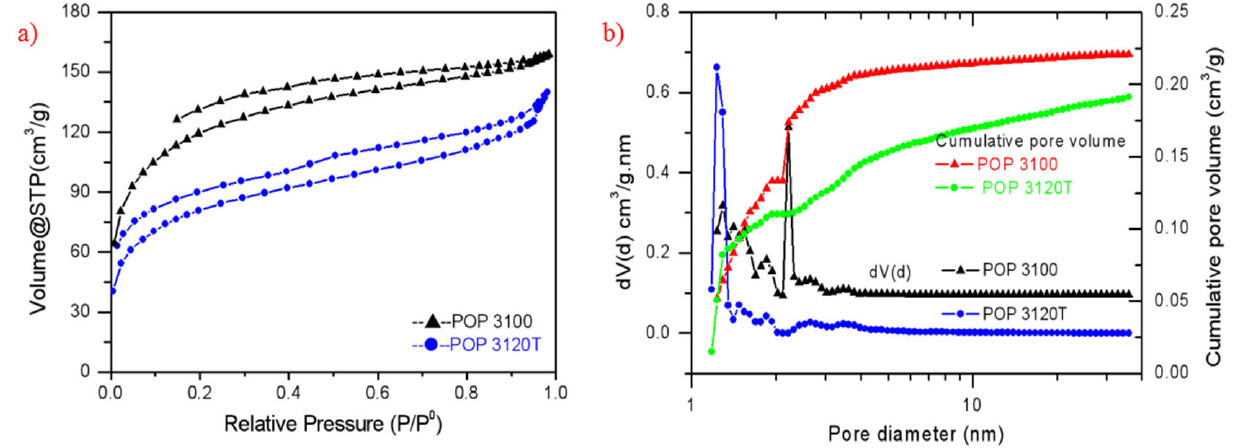
Figure 1. ( a ) Isotherm curves of POP3120T and POP3100; ( b ) pore size distribution curves based on nonlocal density functional theory (NLDFT) dV(d) vs. d (V: pore volume, d: pore diameter (Left); cumulative PV (Right).